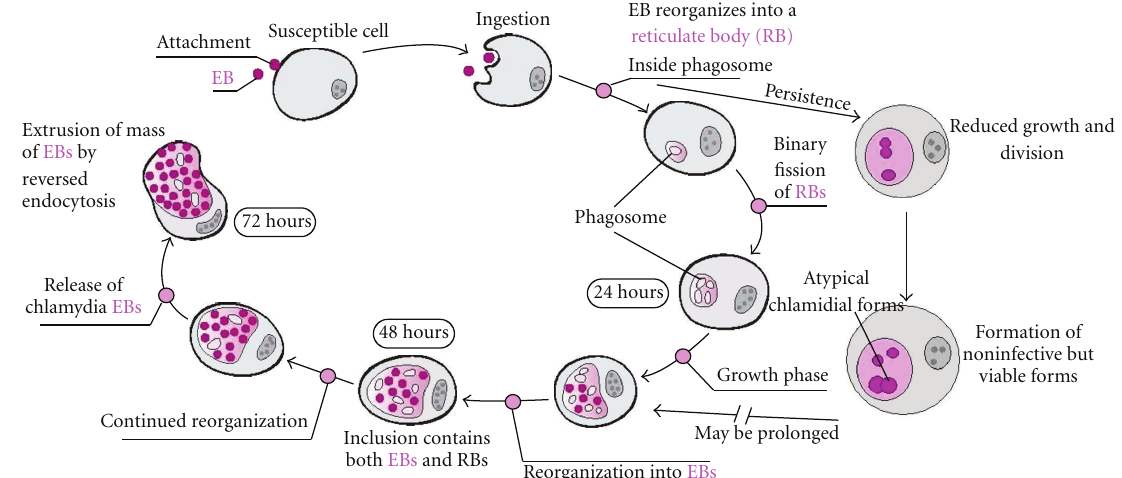
Figure 2: The life cycle of genital serovars of C. trachomatis. The chlamydial growth cycle involves transformation between distinct forms: the elementary body (EB) and the reticulate body (RB). The highly infectious EB attaches to nonciliated columnar or cuboidal epithelial cells and induces ingestion by the host cell. EB are metabolically inactive and represent the extracellular C. trachomatis growth form. Once ingested into a phagosome, fusion of the phagosome with the host lysosome is prevented, a highly unusual occurrence that ensures EB survival. The EB reorganizes within the phagosome into a metabolically active RB. RBs are noninfectious but can replicate and do so by binary fission. Several stimuli, including antibiotic and IFN γ exposure, can drive chlamydia into a persistent state, which lasts in vitro until removal of the exogenous stressor. If persistence is avoided, or if infection is reactivated from persistence, the RB will ultimately reorganize back into EB, which will be released from the host cell to infect surrounding epithelial cells (reproduced with permission